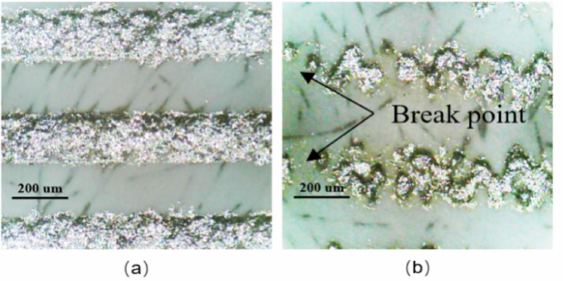
Figure 8. Typical morphology of interdigitated electrodes: ( a ) well-printed electrodes, ( b ) bad- printed